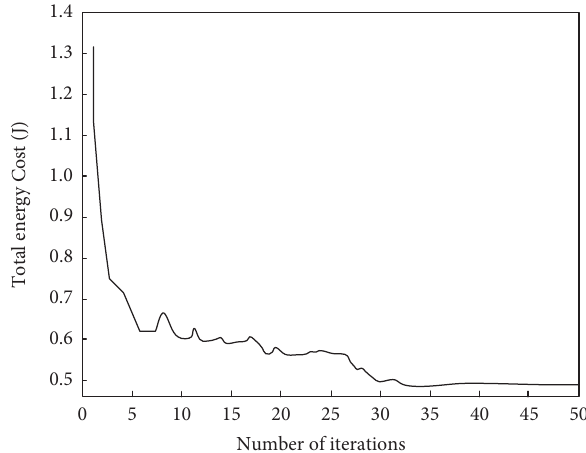
Figure 4: The relationship between the total cost of algorithm and the number of iterations.